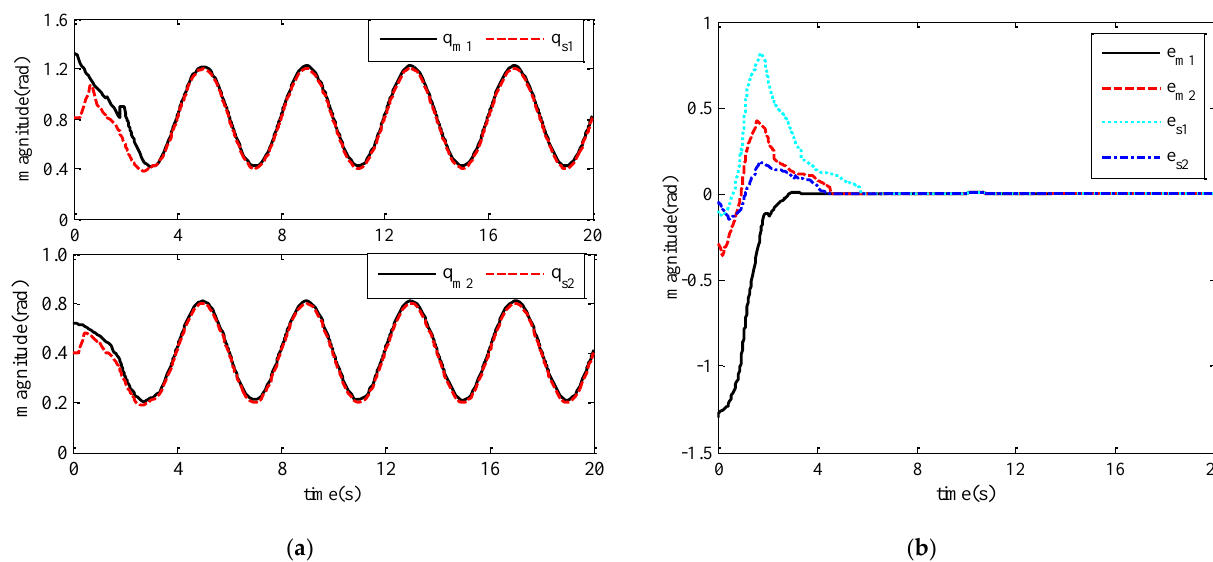
Figure 4. Tracking performance between master and slave robots. ( a ) Tracking of the joint position of the master and slave robots; ( b ) Tracking error of the joint position of the master and slave robots.